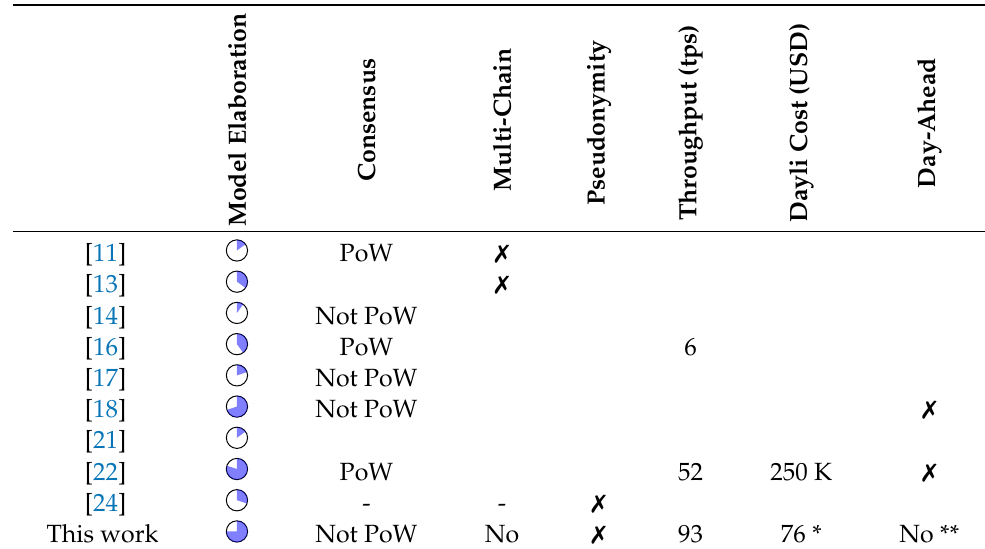
Table 11. Results comparison with related